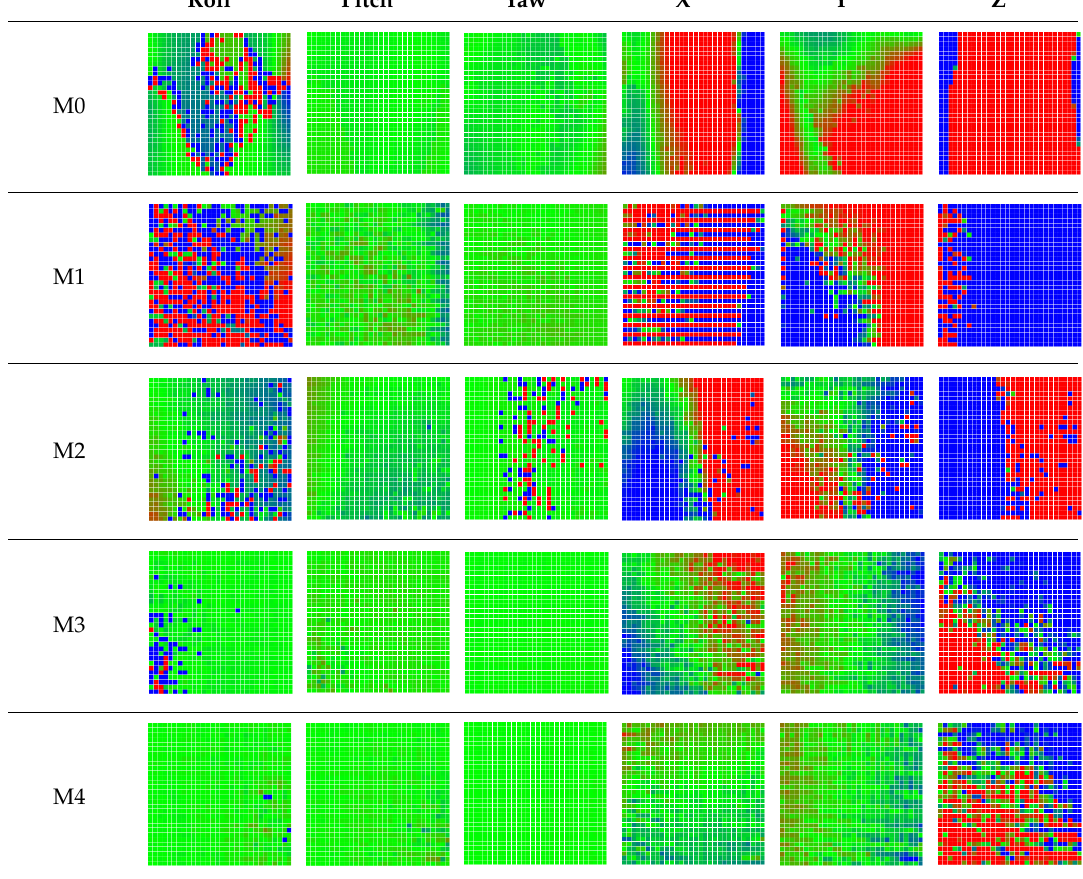
Table 8. Histogram of deviations for the measured data. The normal to the tag was parallel with the camera Z-axis. The bars further from the center of the bar graph represent the count of measurements with more significant deviations.